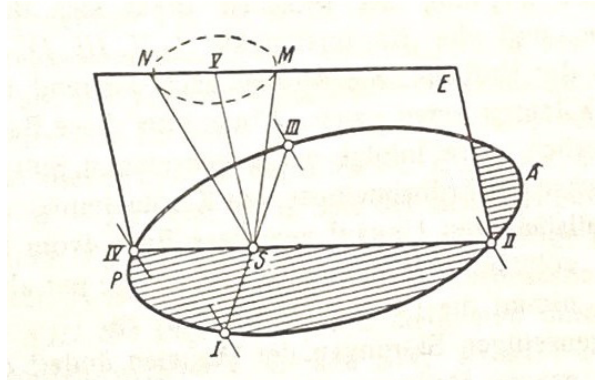
Figure 3. The figure shows all astronomical elements that have an influence in modulating the amount of insolation. Reprinted from Kanon der Erdbestrahlung und seine Anwendung auf das Eiszeiten- problem (p. 247) by Milankovitch (1941), Royal Serbian Academy Special Publications.